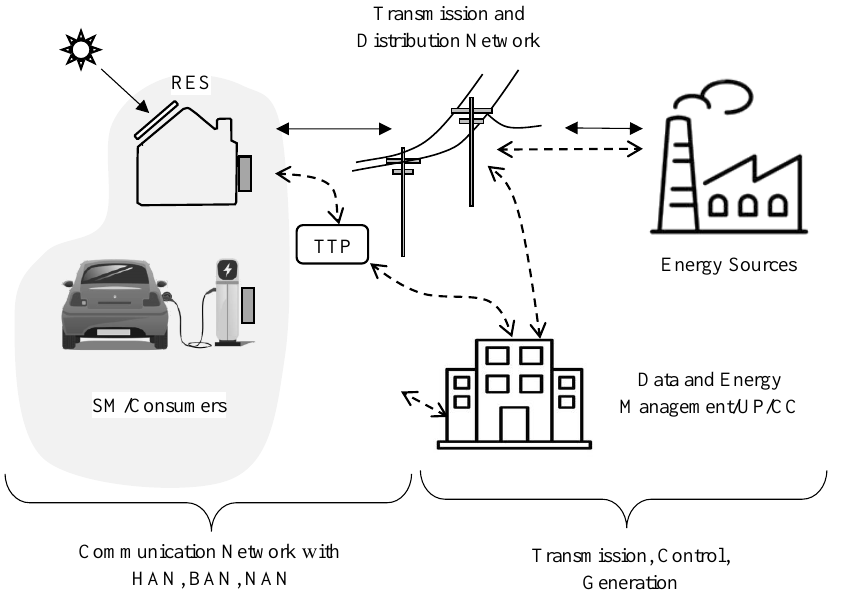
Figure 1. A typical Smart Grid infrastructure (based on [11]). The solid lines denote flow of power, and the dashed lines denote the information